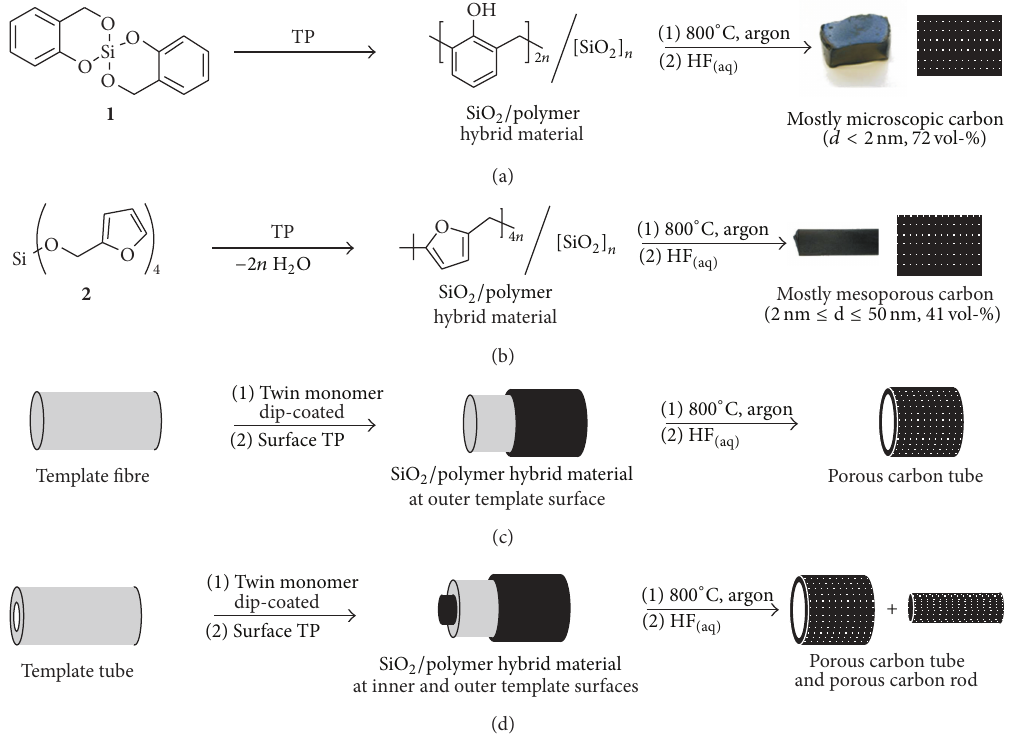
Figure 1: (a) Synthesis of mostly microporous ( 𝑑 < 2 nm, 72vol-%) carbon by acid induced TP of 1 ; (b) synthesis of mostly mesoporous carbon (2nm ≤ 𝑑 ≤ 50 nm, 41vol-%) by TP of 2 ; principle of template assisted TP on (c) template fibres and (d) at template tubes.